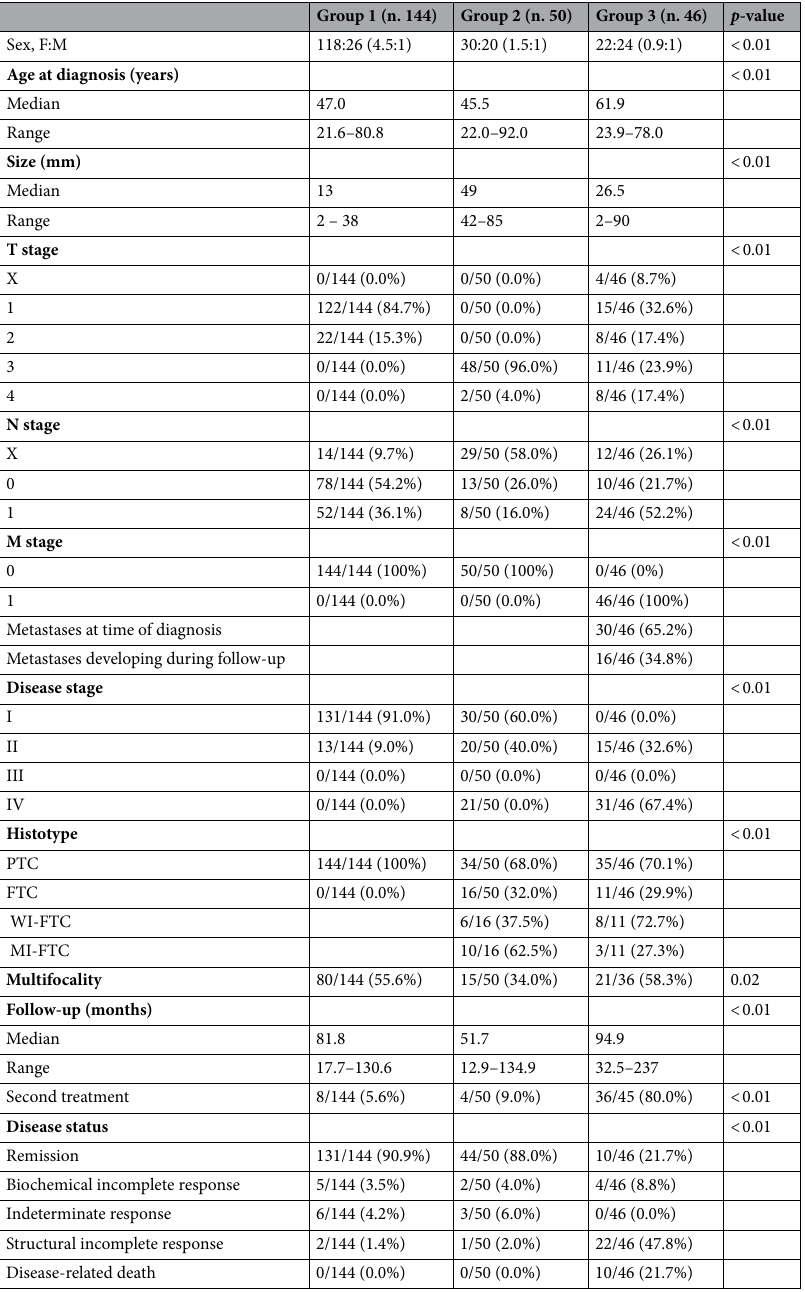
Table 1. Clinical-pathological characteristics of the three groups. PTC papillary thyroid carcinoma, FTC follicular thyroid carcinoma, WI-FTC widely-invasive follicular thyroid carcinoma, MI-FTC minimally- invasive follicular thyroid carcinoma, FU